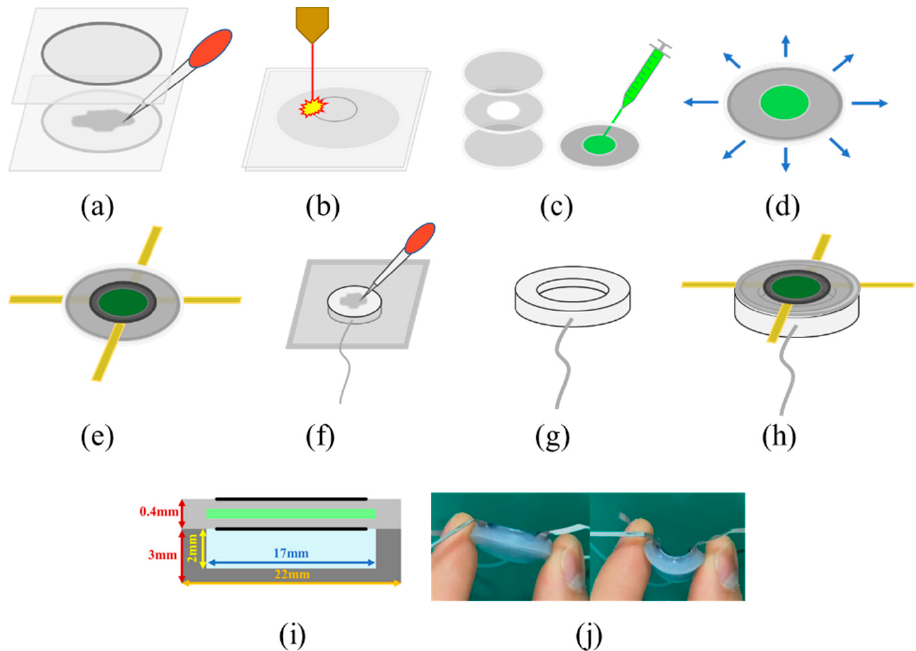
Figure 3. The preparation process of the SEHPA. ( a ) Preparation of silicone film. ( b ) Laser cutting. ( c ) Building a sandwich and injecting dielectric layer. ( d ) Pre-stretching of the sandwich structure. ( e ) Coating MWCNT electrodes. ( f ) Preparation of chamber. ( g ) Demolding of silicone air cavity. ( h ) Integration into SEHPA. ( i ) Size parameters of SEHPA. ( j ) Deformation of the